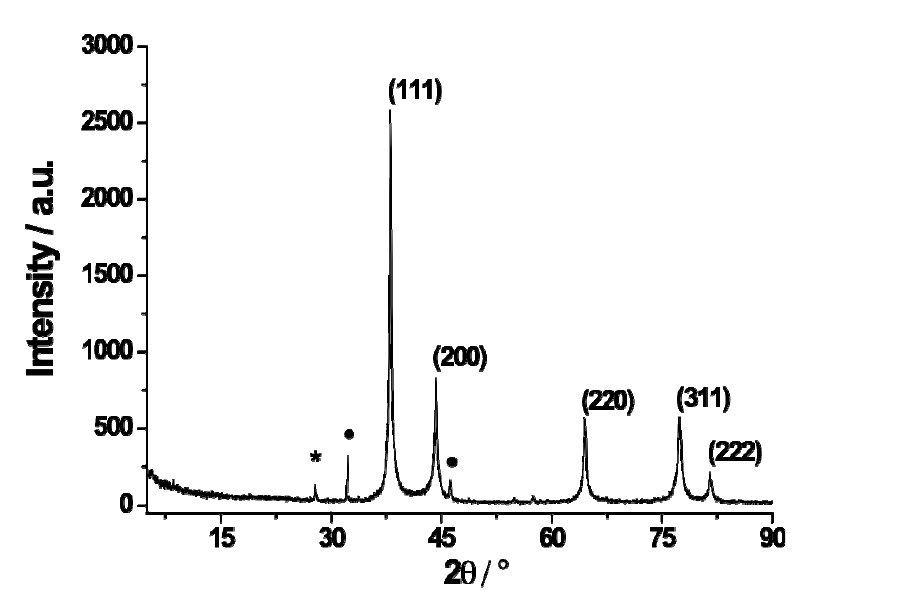
Figure 4. The XRPD pattern for the investigated AgNPs of Ag (0). The peaks marked with * and • are due to Ag 3 O 4 and AgO, respectively.